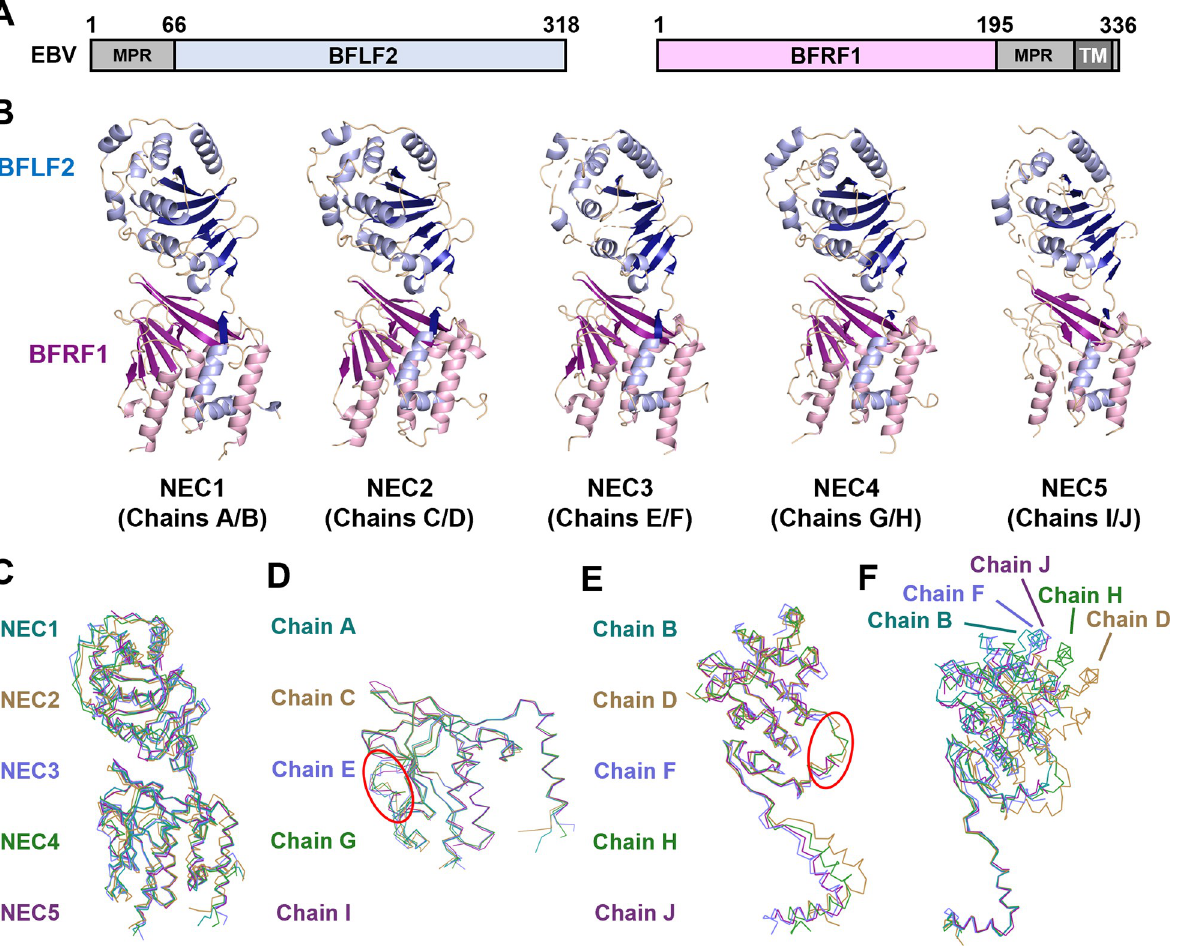
Fig 1. Crystal structure of EBV NEC. (A) Schematic depicting construct boundaries for EBV NEC (rcsb pdb 7t7i). BFLF2 is shown in blue while BFRF1 is shown in pink. Grey regions denote residues omitted from constructs including the membrane-proximal regions (MPRs) and the transmembrane (TM) region in darker grey. (B) Crystal structures of the 5 EBV NEC copies in the asymmetric unit with chain IDs. BFLF2 is shown in blue with light blue for α -helices and dark blue for β -strands. BFRF1 is shown in pink with light pink for α -helices and dark pink for β -strands. (C) Ribbon overlay aligned to NEC2 (Chains C+D) for the 5 copies of EBV NEC in the asymmetric unit. NEC1 (teal), NEC2 (gold), NEC3 (light purple), NEC4 (green), and NEC5 (purple). (D) Ribbon overlay aligned to chain A for the 5 copies of BFRF1 in the asymmetric unit. Red oval highlights differences in β 5/ β 6 loop. Chain A (teal), chain C (gold), chain E (light purple), chain G (green), and chain I (purple). (E) Ribbon overlay aligned to the globular domain of B for the 5 copies of BFLF2 in the asymmetric unit. Red oval highlights differences in β 2/ β 3 loop. Chain B (teal), chain D (gold), chain F (light purple), chain H (green), and chain J (purple). (F) Ribbon overlay of the 5 copies of BFLF2 aligned to BFRF1 chain A (hidden) in the asymmetric unit. Same coloring as (E). Images were created in PyMol [44].